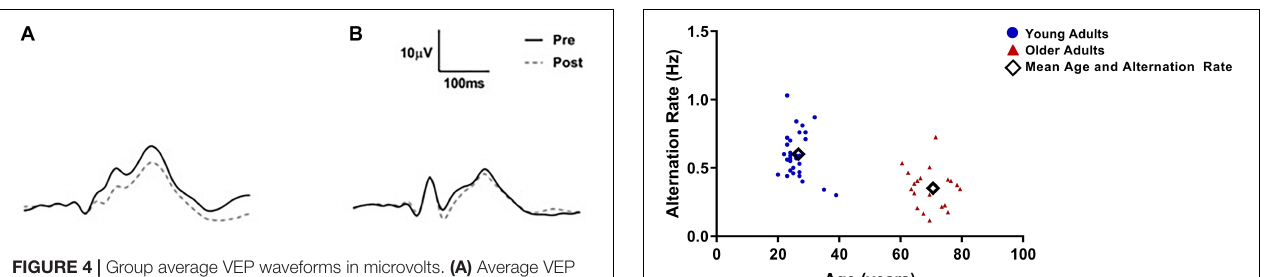
analysis. Therefore, 29 young and 18 older adult datasets were